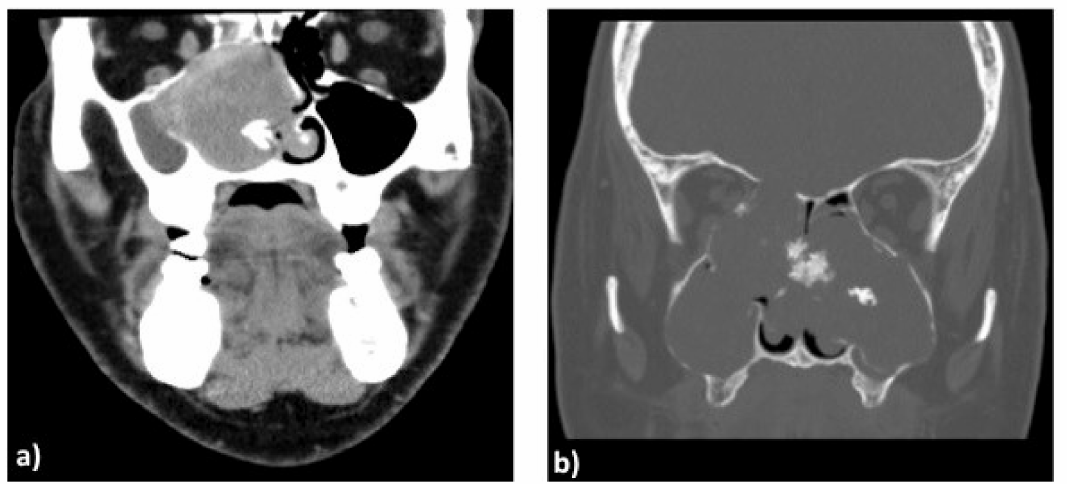
Figure 2. Coronal computed tomography scan showing a large solitary fibrous tumour (SFT) of the right nostril ( a ) and bilateral chondrosarcoma ( b ). The hyperostosis of nasal septum indicates the origin of SFT that compresses the medial wall of maxillary sinus, while in ( b ) it is showed the invasion of maxillary sinus